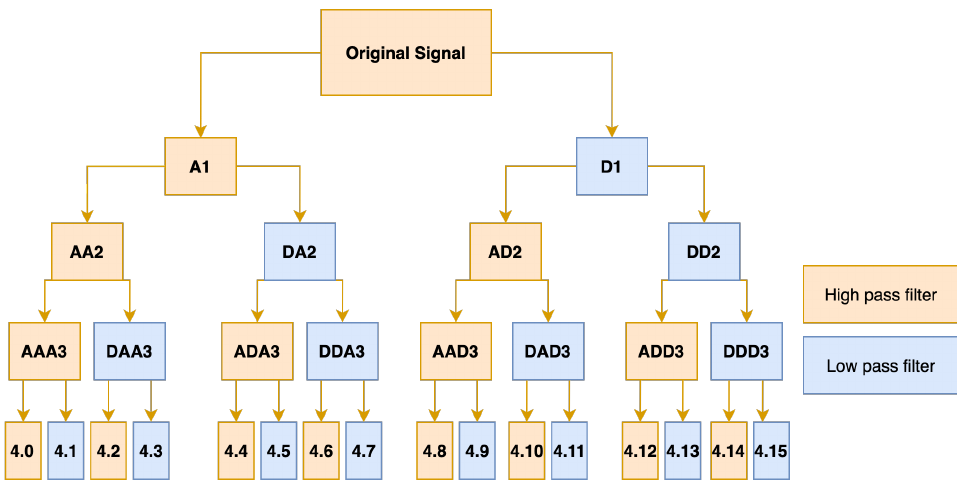
Figure 4. The structure of WPD.